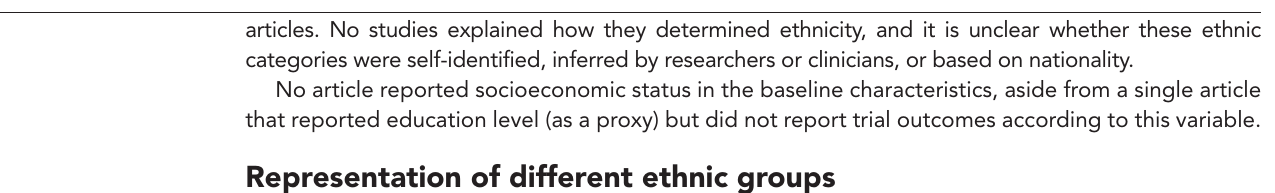
Figure 1 The breakdown of ethnic groups in the trials that informed the review questions of the NICE guideline. Ethnic categories are presented as documented in the original articles. The articles not reporting ethnicity are grouped on the left of the figure, and the other articles are listed on the right in descending order of the time of